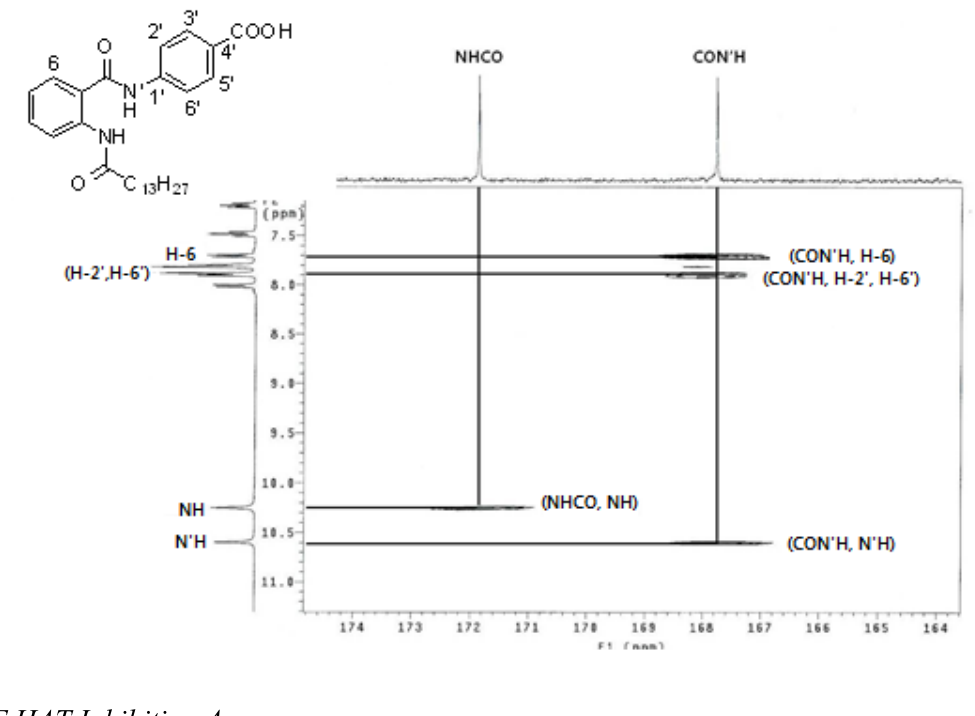
Figure 2. 1 H- 13 C HMBC spectrum of 16 (CDCl